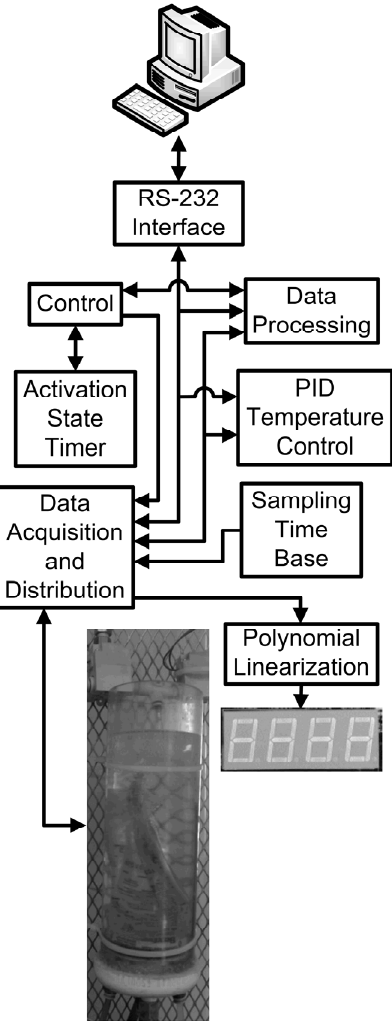
Figure 1. Block diagram of the carbon dioxide-methane gas sensor with the digital